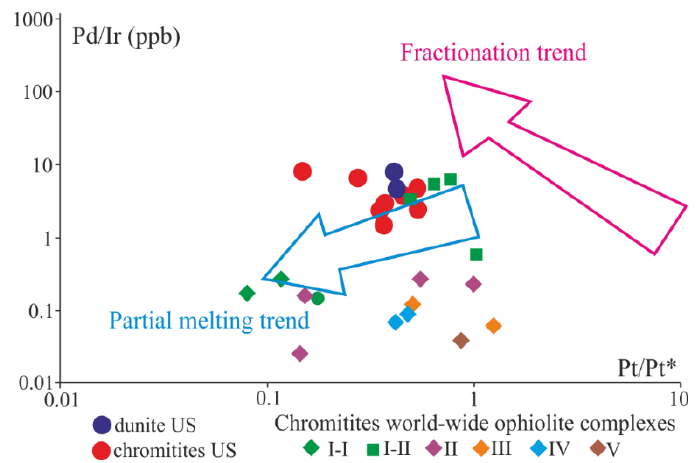
Figure 11. Plot of Pd/Ir versus Pt/Pt* for mantle peridotite and chromitites of the USO. The Pt anomaly is calculated as follows: Pt/[Pt]* = (Pt/8.3) × √(Rh/1.6) × (Pd/4.4) [8]. US—Ulan-Sar’dag ophiolite; ophiolite complexes from around the world: I—Wadi Al Hwanet ophiolite, Saudi Arabia [47]; II—Oman ophiolite, Semail [48]; III—Veria ophiolite, Greece [49]; IV—Shetland Ophiolite Complex, Scotland [50]; V—Ray-Iz ophiolite, Russia [51].